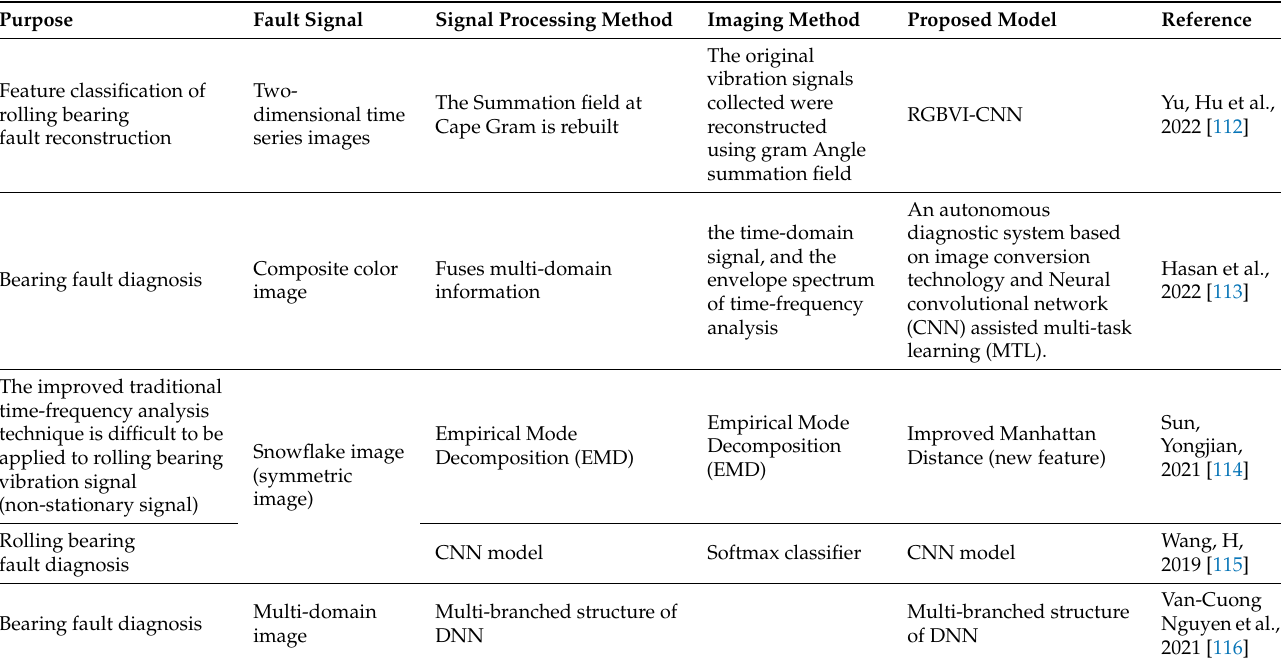
Table 12. Summary and comparison table of other types of vibration image